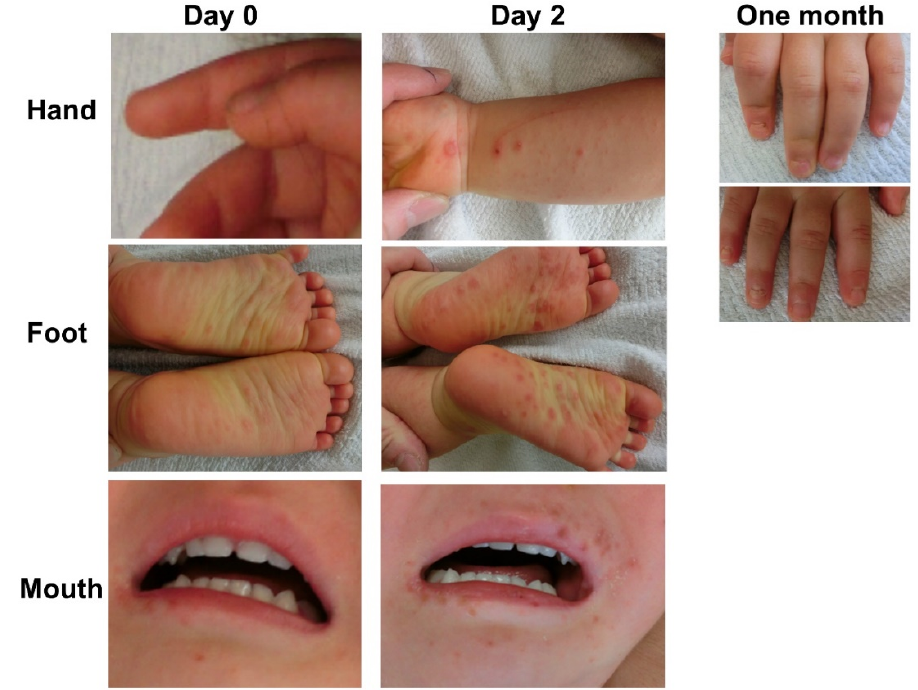
Figure 3. Photographs of a patient with the HFMD caused by CV-A6. Day 0 and 2 after the onset of the disease in hands, feet, and mouth. After one month, onycholysis was observed for both hands (foot and mouth lesions healed after one month). Pictures were taken with the informed consent of patients.